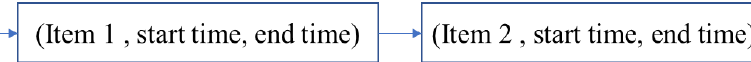
Figure 10. Time node of data structure diagram.